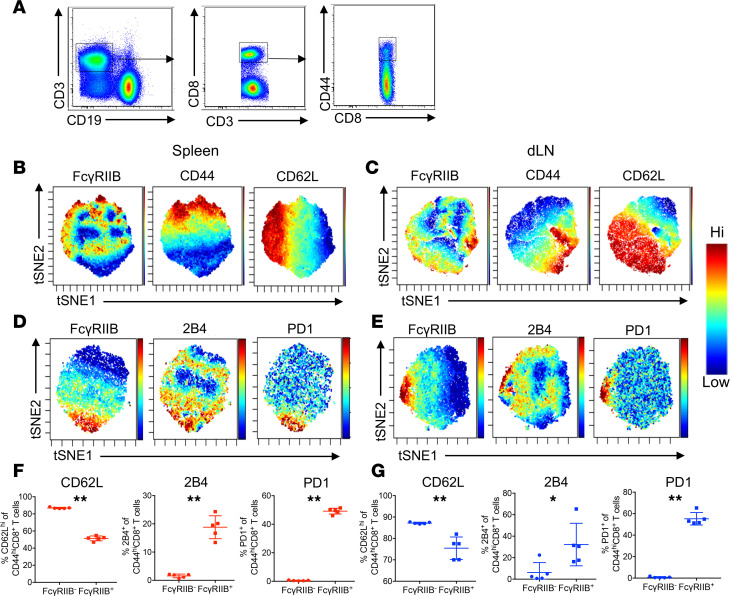
FcγRIIB is associated with 2B4 and PD-1 expression on CD44hiCD8+ T cells in the spleen and dLN in mice with melanoma.106 B16-OVA melanoma cells were subcutaneously injected into the right flank of C57BL/6 mice on day 0. Spleen and dLN were harvested on day 14. (A) Using conventional fluorescence-based flow cytometry, bulk CD3+CD8+ T cells (B and C) and CD44hiCD8+ CD3+ T cells (D and E) were gated and exported as FCS files for viSNE analysis. (B) viSNE maps showing the intensity of FcγRIIB, CD44, and CD62L expression on CD8+ T cells in the spleen. (C) viSNE maps showing intensity of FcγRIIB, CD44, and CD62L expression on CD8+ T cells in the dLN. (D) viSNE maps showing intensity of expression of FcγRIIB, 2B4, and PD-1 on CD44hiCD8+ T cells in the spleen. (E) viSNE maps showing intensity of expression of FcγRIIB, 2B4, and PD-1 on CD44hiCD8+ T cells in the dLN. (F) Summary data of the frequency of CD62Lhi, 2B4+, and PD1+FcγRIIB+ and FcγRIIB– CD44hiCD8+ T cells in the spleen. (G) Summary data of the frequency of CD62Lhi, 2B4+, and PD1+FcγRIIB+ and FcγRIIB– CD44hiCD8+ T cells in the dLN. Data shown are representative of 2 independent experiments; n = 5 mice/group/experiment. Mann-Whitney U test, *P < 0.05, **P < 0.005. dLN, draining lymph node.